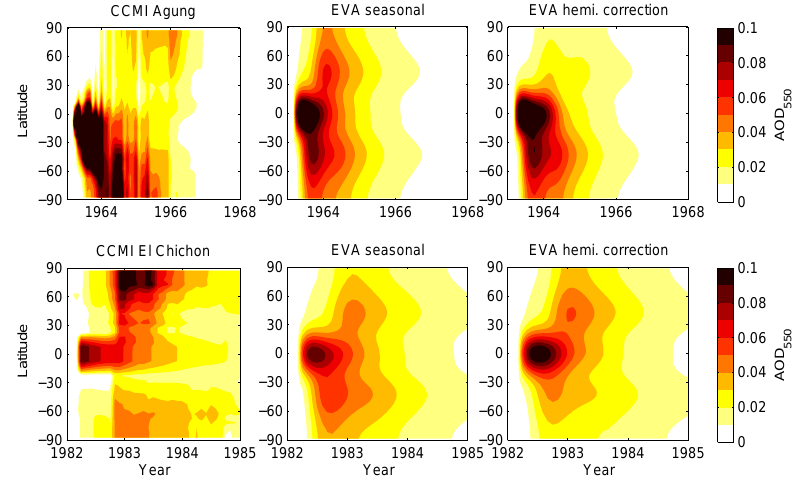
Figure 12. Illustration of hemispheric asymmetry correction in EVA. Left: CCMI representations of the zonal mean AOD for (top) Agung and (bottom) El Chichón. EVA emulations (middle) without and (right) with hemispheric asymmetry correction, as described in the text.